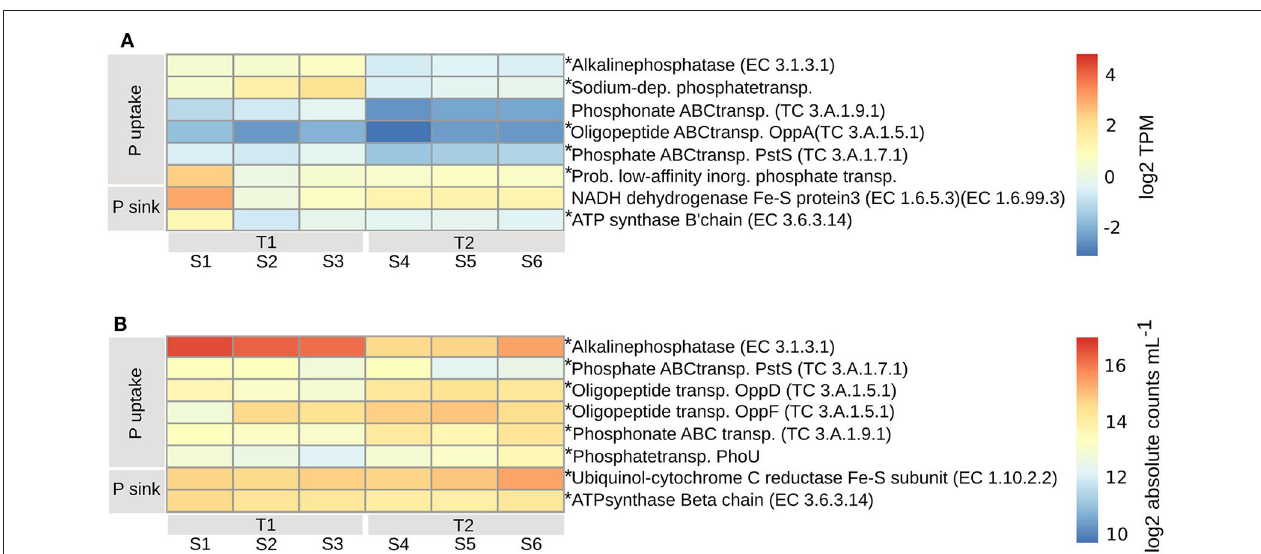
FIGURE 6 | Transcripts involved in phosphorous uptake and assimilation for PE (A) and BAC (B) , calculated according to legend in Figure 4 . Asterisks indicate enzymes that were significantly changed from T1 to T2 (adjusted p < 0.01). T1, first timepoint (samples S1–S3); T2, second timepoint (samples S4–S6); P uptake , uptake of phosphorous; P sink , phosphorous